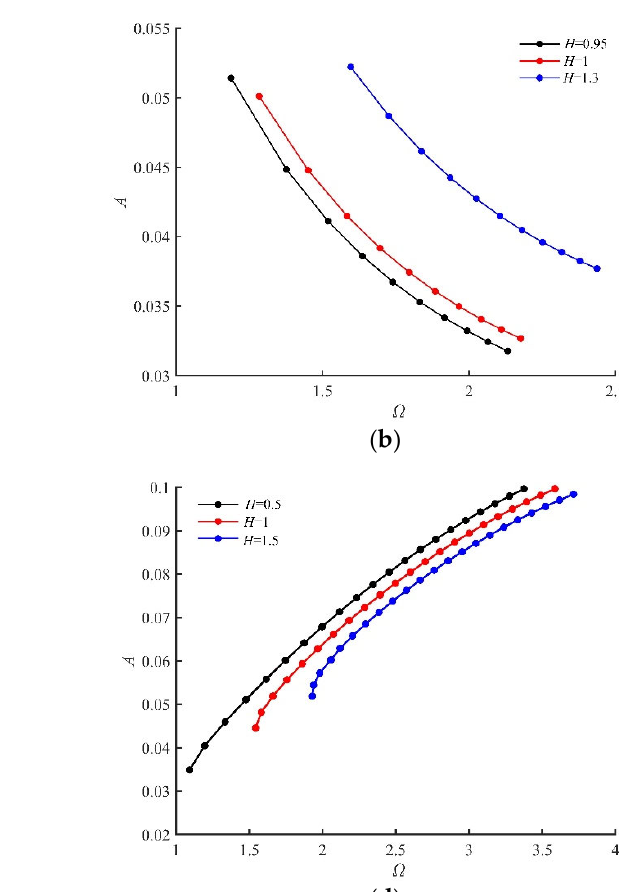
Figure 8. ( a ) The distribution of attractors without the frequency island; ( b ) the time history of vi ‐ bration, the initial conditions of black line, are selected as   1,0 , the initial conditions of red line are selected as   0,0 .